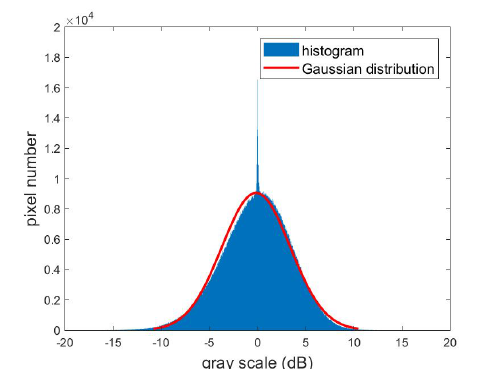
Figure 13. The histograms of foreground image.